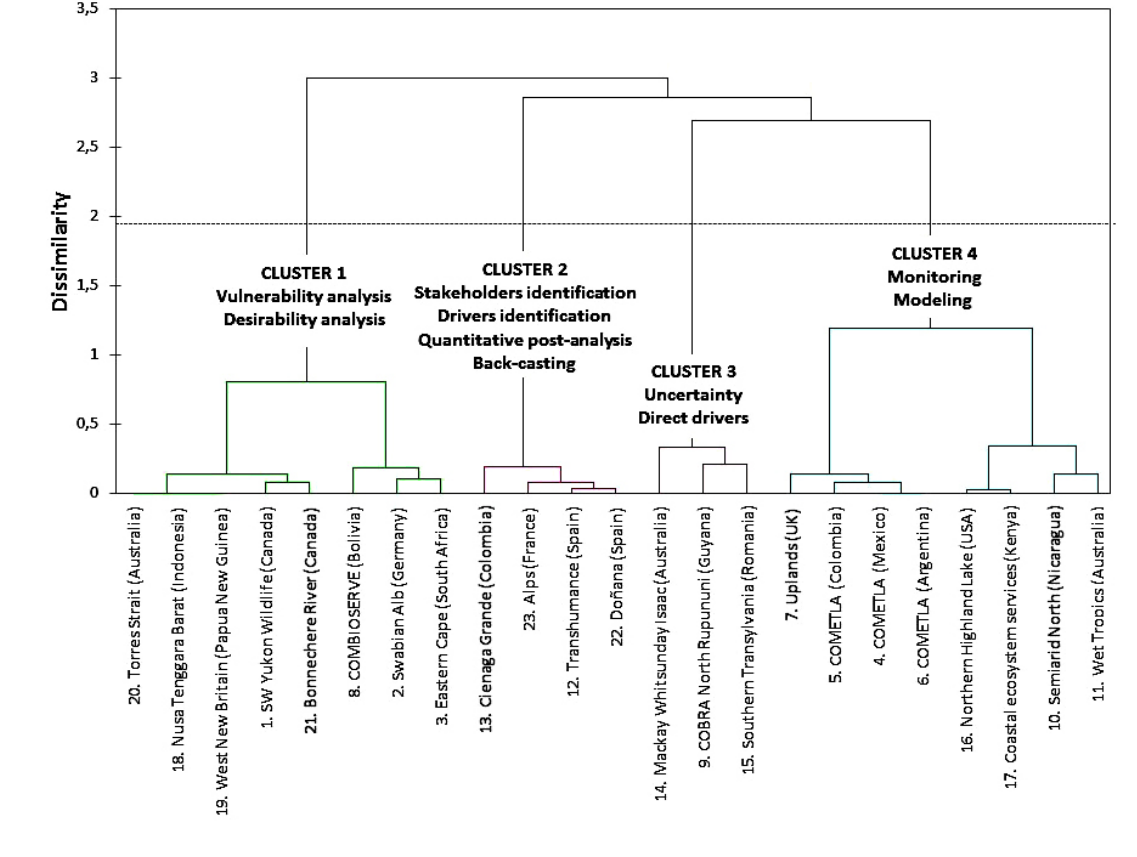
Fig. 5 . Clusters resulting from the hierarchical cluster analysis with the corresponding names of the case